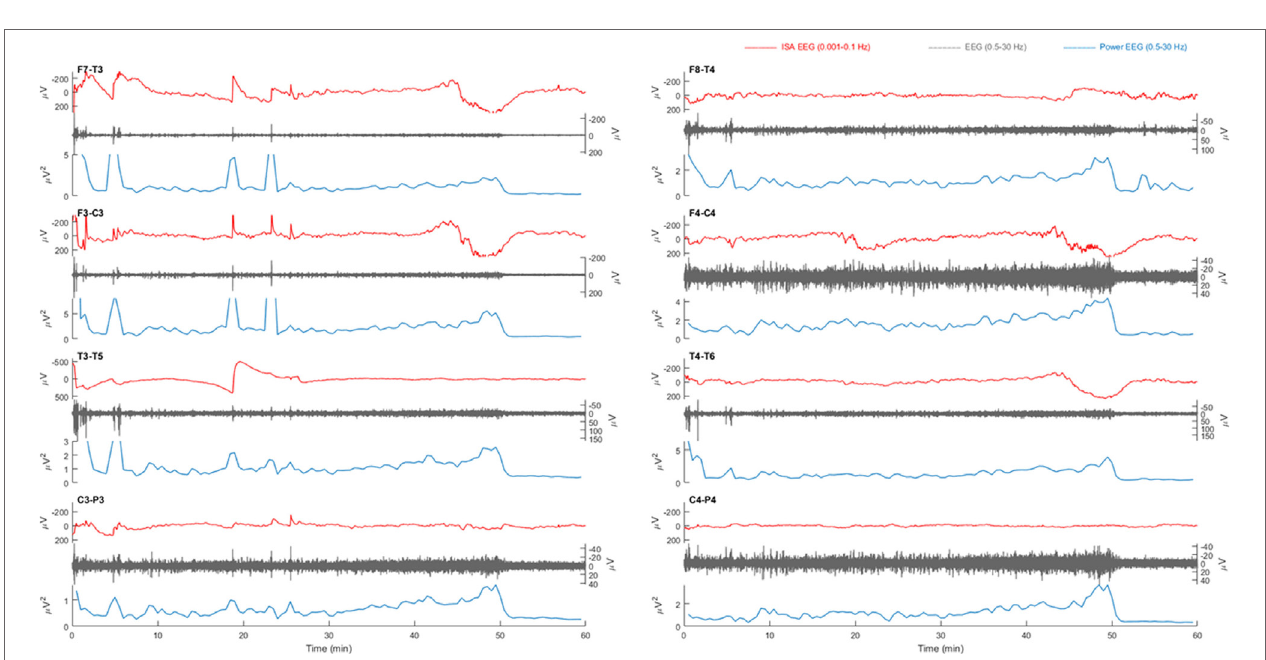
FigUre 3 | Example of a 1 h electroencephalography (EEG) overview from patient 3 with a left sided middle cerebral artery infarction. Electrode pairs F7-T3, F3-C3, T3-T5, and C3-P3 over the left hemisphere and F8-T4, F4-C4, T4-T6, and C4-P4 over the right hemisphere are displayed. In F7-T3, a possible slow potential change (SPC) is visible in the infraslow activity (ISA) band (0.001–0.1 Hz, red) at, e.g., 18 min. During this activity, there is an increase of faster activity (0.5–30 Hz, gray). On all electrode pairs, a sudden drop power of fast activities (blue) is present at 50 min. However, there is neither clear simultaneous SPC nor a unilateral presentation with spreading, as would be expected in cortical spreading depolarization (CSD).